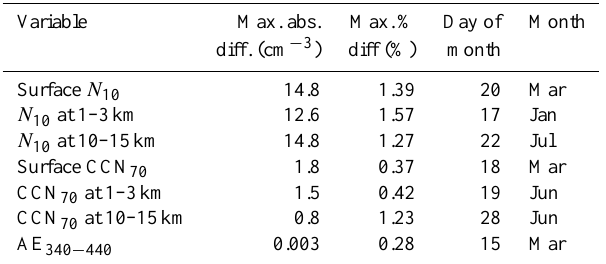
Table 5. The maximum absolute difference between unperturbed and perturbed data, as both an absolute value and a percentage, as well as the day and the month on which the maximum difference